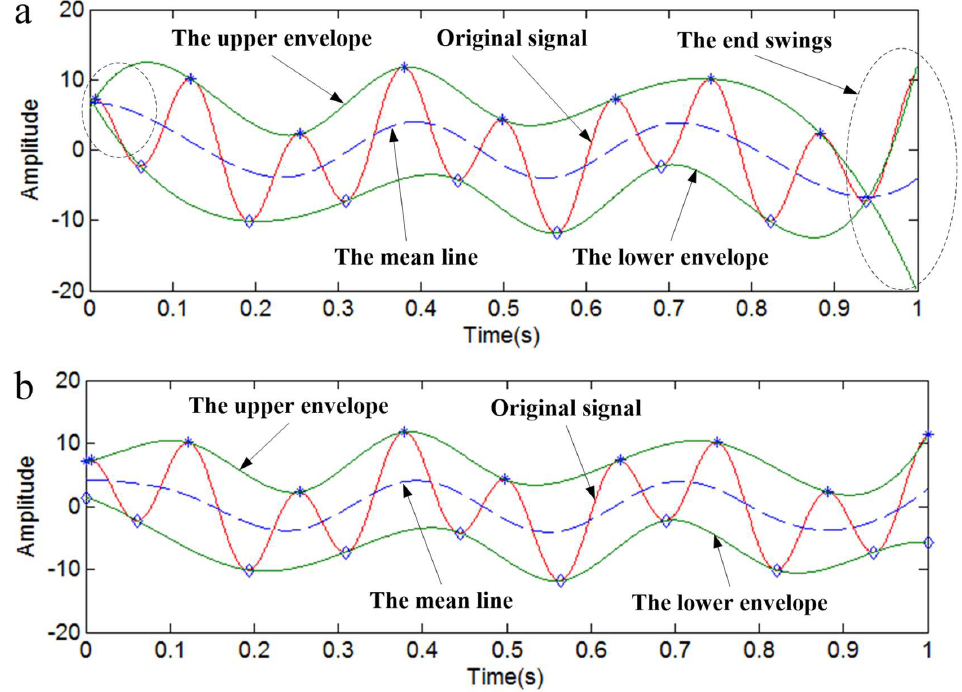
Figure 2. The envelopes. ( a ) The original envelopes; ( b ) The envelopes that were obtained by the local linear extrapolation method.